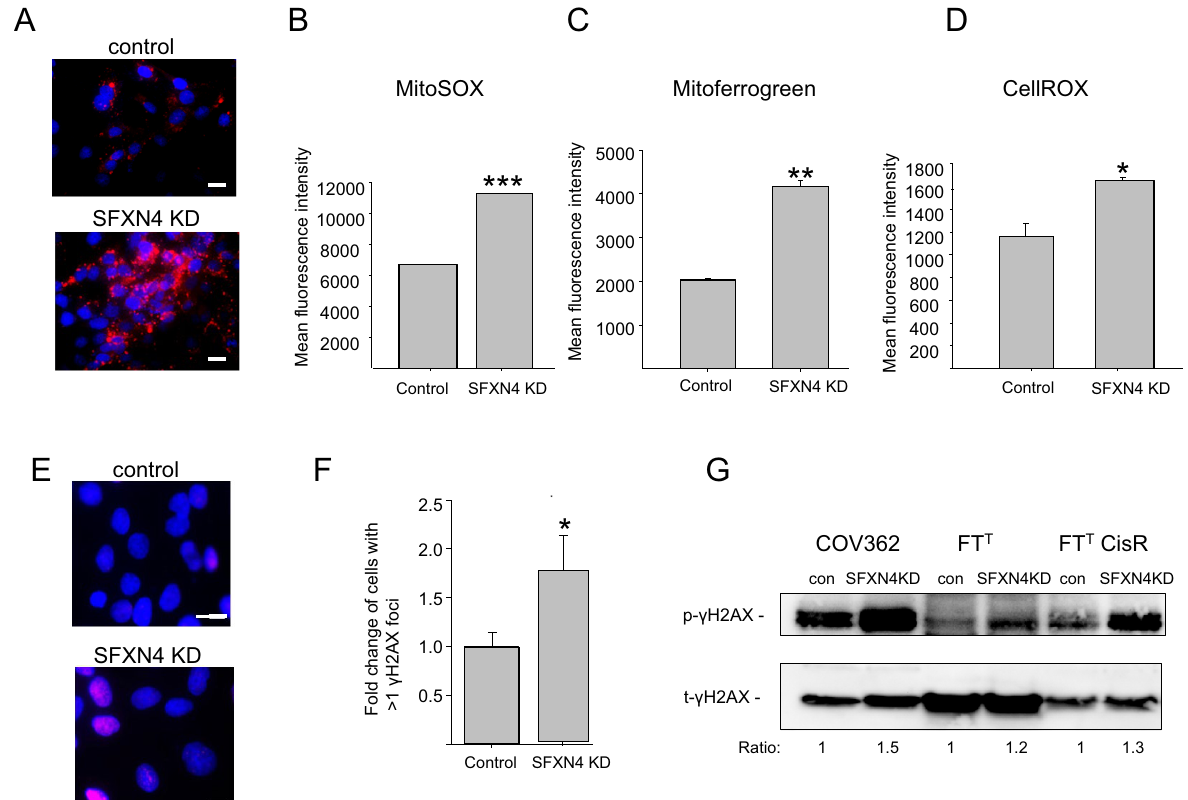
Figure 3. SFXN4 KD increases mitochondrial superoxide, mitochondrial iron, cellular ROS and p-γH2AX. ( A ) COV362 control and SFXN4 knockdown cells were stained with MitoSOX and visualized using fluorescence microscopy ( B ) quantification of MitoSOX positive cells in control and SFXN4 knockdown cells. ( C ) Quantification of mitochondrial iron measured by mitoferrogreen staining in control and siSFXN4 knockdown cells. ( D ) Cellular reactive oxygen species in control and SFXN4 knockdown cells quantified using CellROX. ( E ) Representative image of COV362 control and SFXN4 knockdown cells stained with p-γH2AX antibody (red) and counterstained with Dapi (blue). ( F ) Quantification of γH2AX foci. ( G ) Western blot analysis of p-γH2AX and t-γH2AX in control and SFXN4 knockdown cells. Uncropped images are presented in Supplemental data (Supplemental Fig. S10). Scalebar in ( A ) and ( E ) is 10 µm. Means and standard deviations of three independent experiments (****p < 1.5E -09; ***p < 2.5E−05; **p < 0.002; *p <